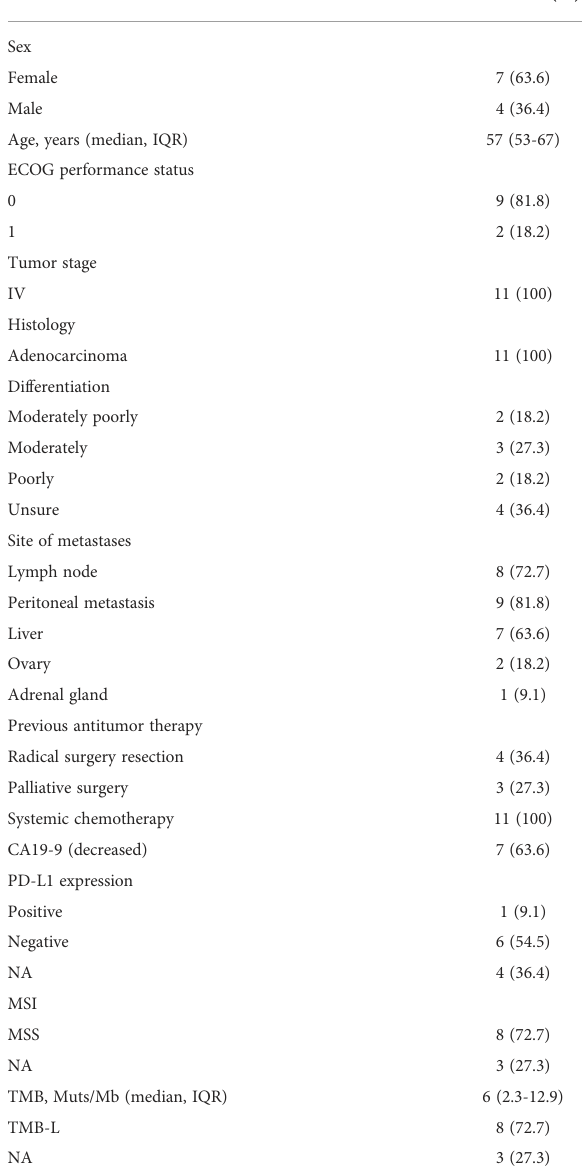
TABLE 1 Baseline patient